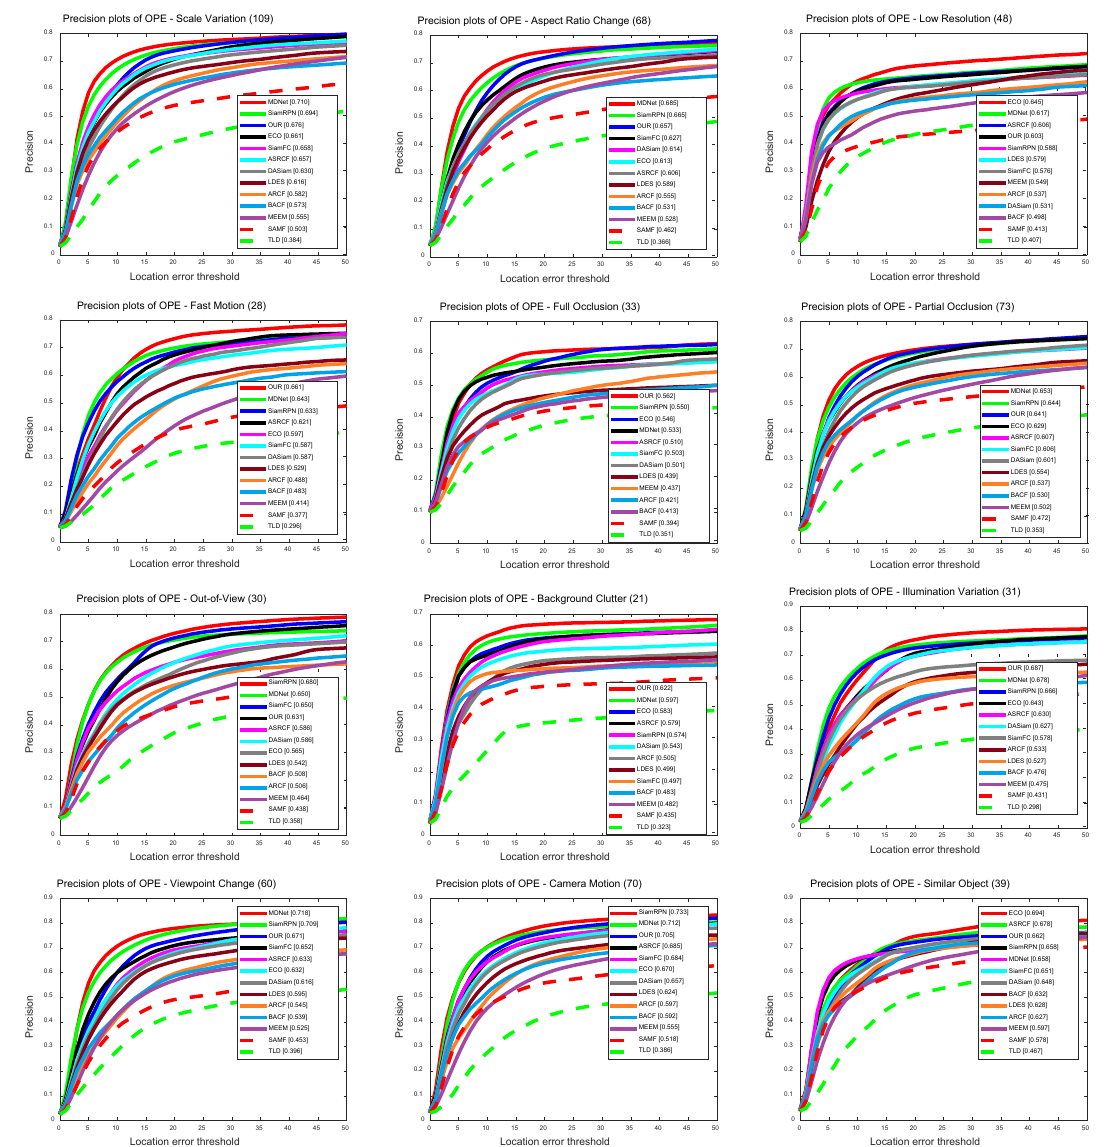
Figure 14. Success plots based on tracking results on the UAV123 [6] dataset in 12 sequence attributes, including: Scale Variation (SV), Aspect Ratio Change (ARC), Low Resolution (LR), Fast Motion (FM), Full Occlusion (FOC), Partial Occlusion (POC), Out-of-View (OV), Background Clutter (BC), Illumination Variation (IV), Viewpoint Change (VC), Camera Motion (CM), and Similar Object (SOB). The legend of overlap success is area-under-the-curve score. The proposed algorithm performs well against state-of-the-art